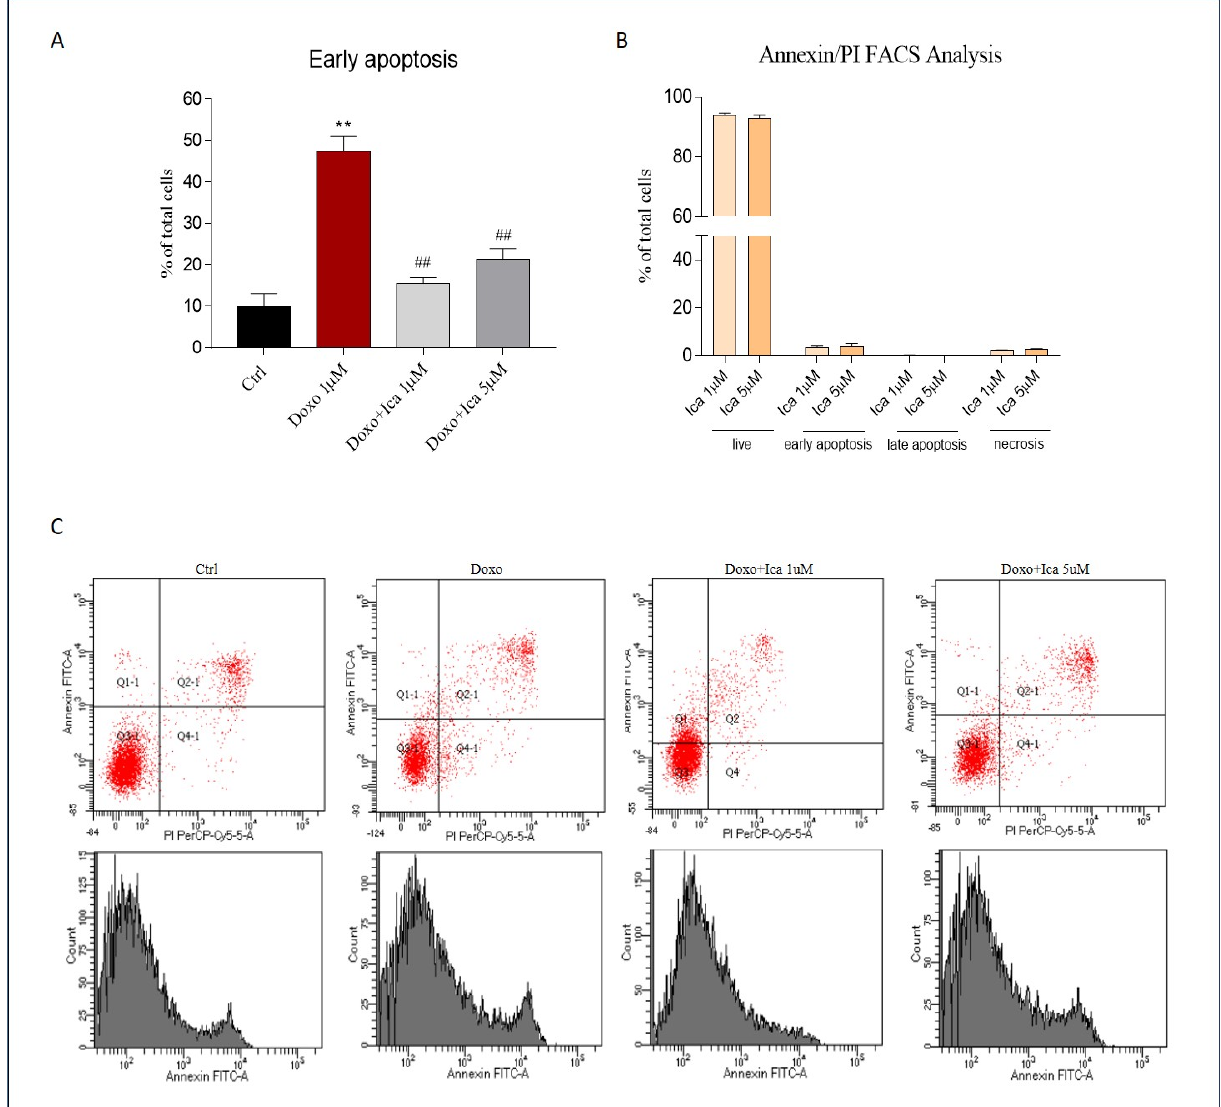
Figure 6. Cytofluorimetric evaluation of the effect of Ica against Doxo-induced apoptotic cell death. ( A ). H9c2 cells treated for 3 h with both Ica 1 μ M and 5 μ M showed no significant apoptotic or necrotic cell death. ( B ). Treatment with Doxo 1 μ M for 24 h resulted in a detrimental increase in apoptotic cell death when compared to Ctrl cells. Conversely, pretreatment of H9c2 cells with Ica 1 μ M and 5 μ M significantly prevented apoptosis. ( C ) . Representative cytofluorimetric dot plot. Data are expressed as means ± SEM.; ** p < 0,01 vs. Ctrl, ## p < 0,01 vs. Doxo; Mann Whitney test ( n = 3). Data is for three independent experiments.